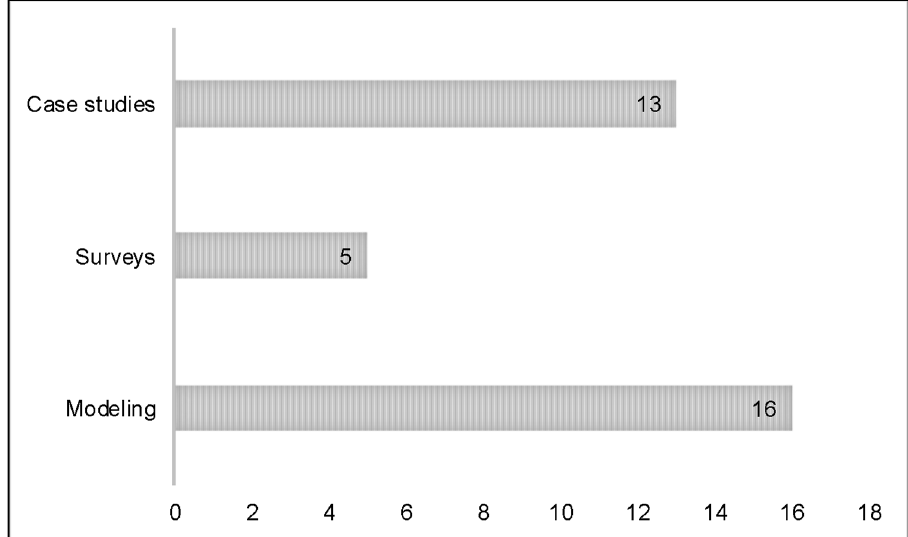
Figure 3. Classification of papers on the main method adopted.